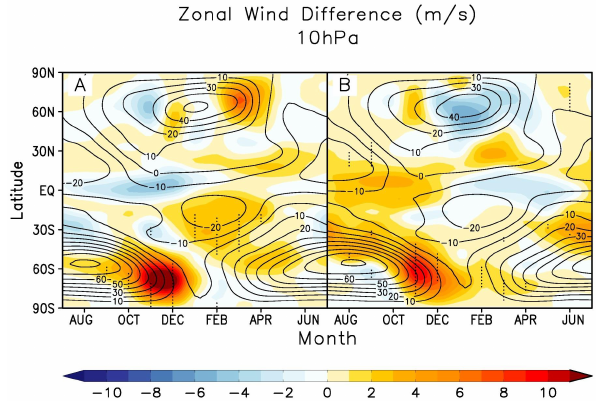
Figure 3: Long-term, monthly and zonal mean total ozone differences (Dobson Units, DU) for Figure 4: Long-term, monthly and zonal mean zonal wind (isolines, m/s) and zonal wind Fig. 3. Long-term, monthly and zonal mean total ozone differences Fig. 4. Long-term, monthly and zonal mean zonal wind (isolines, experiment pairs A (left) and B (right). Negative differences are shown in cold colours and differences (shadings, m/s) for experiment pairs A (left) and B (right) at 10 hPa. Positive (Dobson Units, DU) for experiment pairs A (left) and B (right). positive in warm colours. See Figure 2 for definition of the differences. Differences that exceed ms − 1 ) and zonal wind differences (shadings, ms − 1 ) for experi- differences are shown in warm colours and negative in cold colours. See Figure 2 for definition one standard deviation of the ‘Control’ are stippled. of the differences. Differences that exceed one standard deviation of the ‘Control’ are stippled. Negative differences are shown in cold colours and positive in warm ment pairs A (left) and B (right) at 10hPa. Positive differences are colours. See Fig. 2 for definition of the differences. Differences that shown in warm colours and negative in cold colours. See Fig. 2 for exceed one standard deviation of the “Control” are stippled. definition of the differences. Differences that exceed one standard deviation of the “Control” are